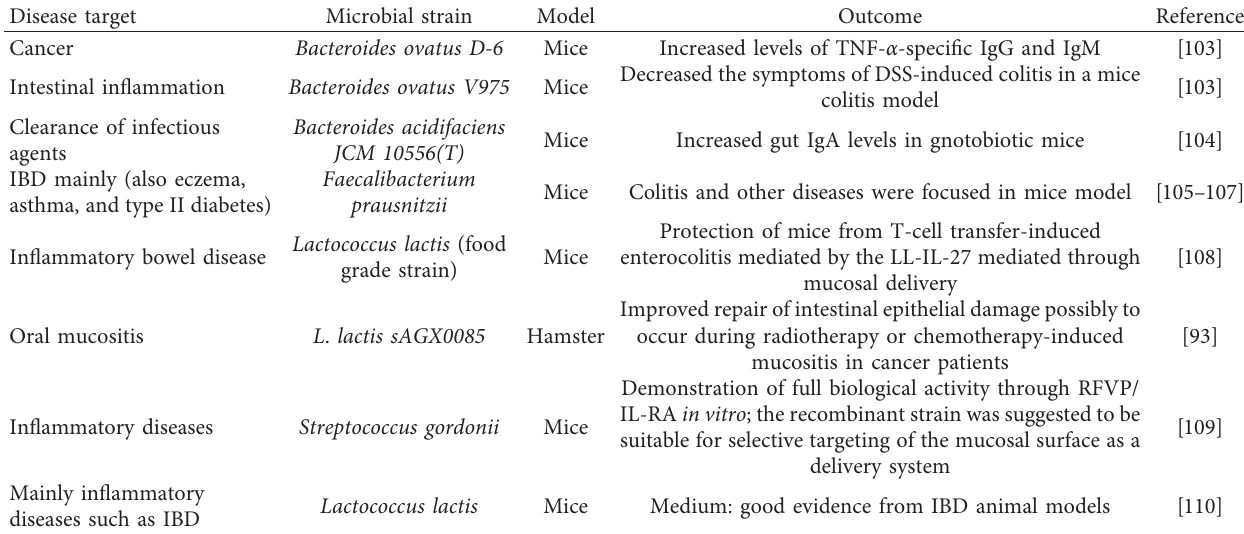
Table 2: Example of genetically modified probiotics microorganisms for use as designer probiotics in animal models. Disease